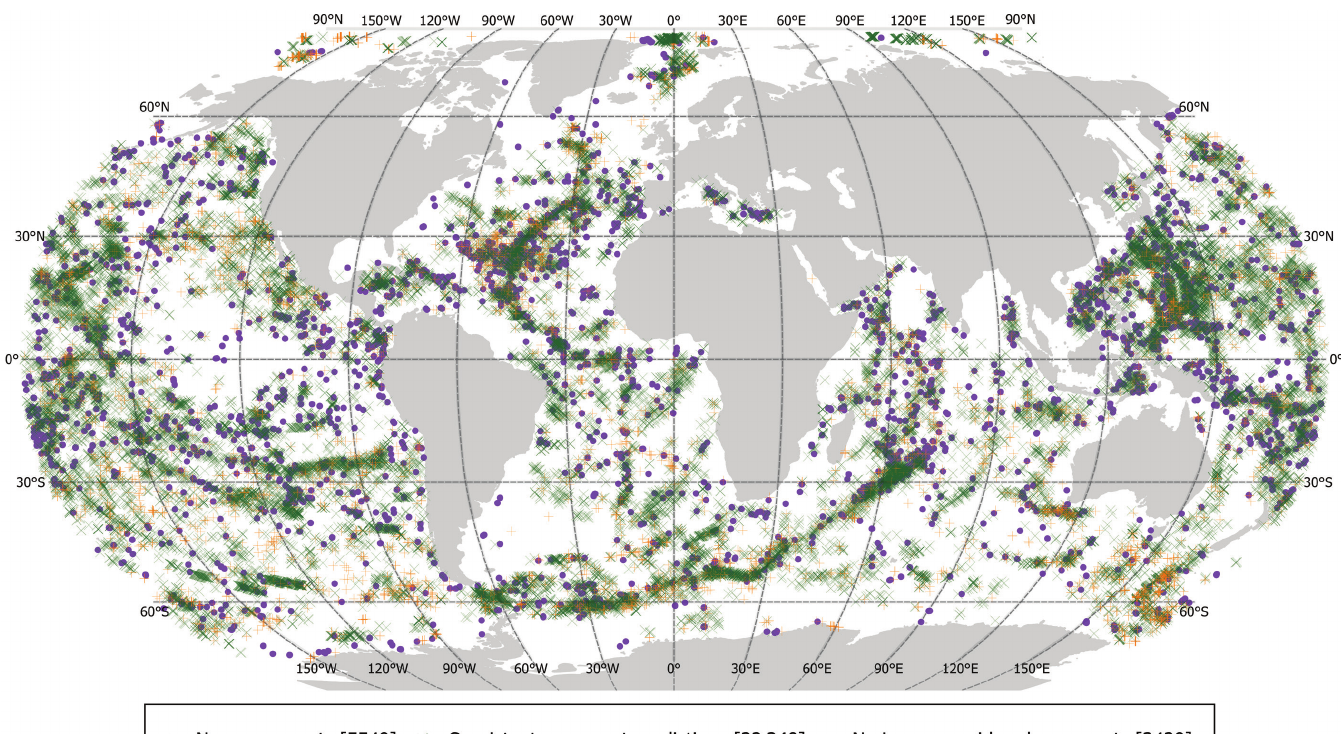
the old dataset (=10% of old seamount predictions) that do not overlap with the seamount bases of the new dataset.